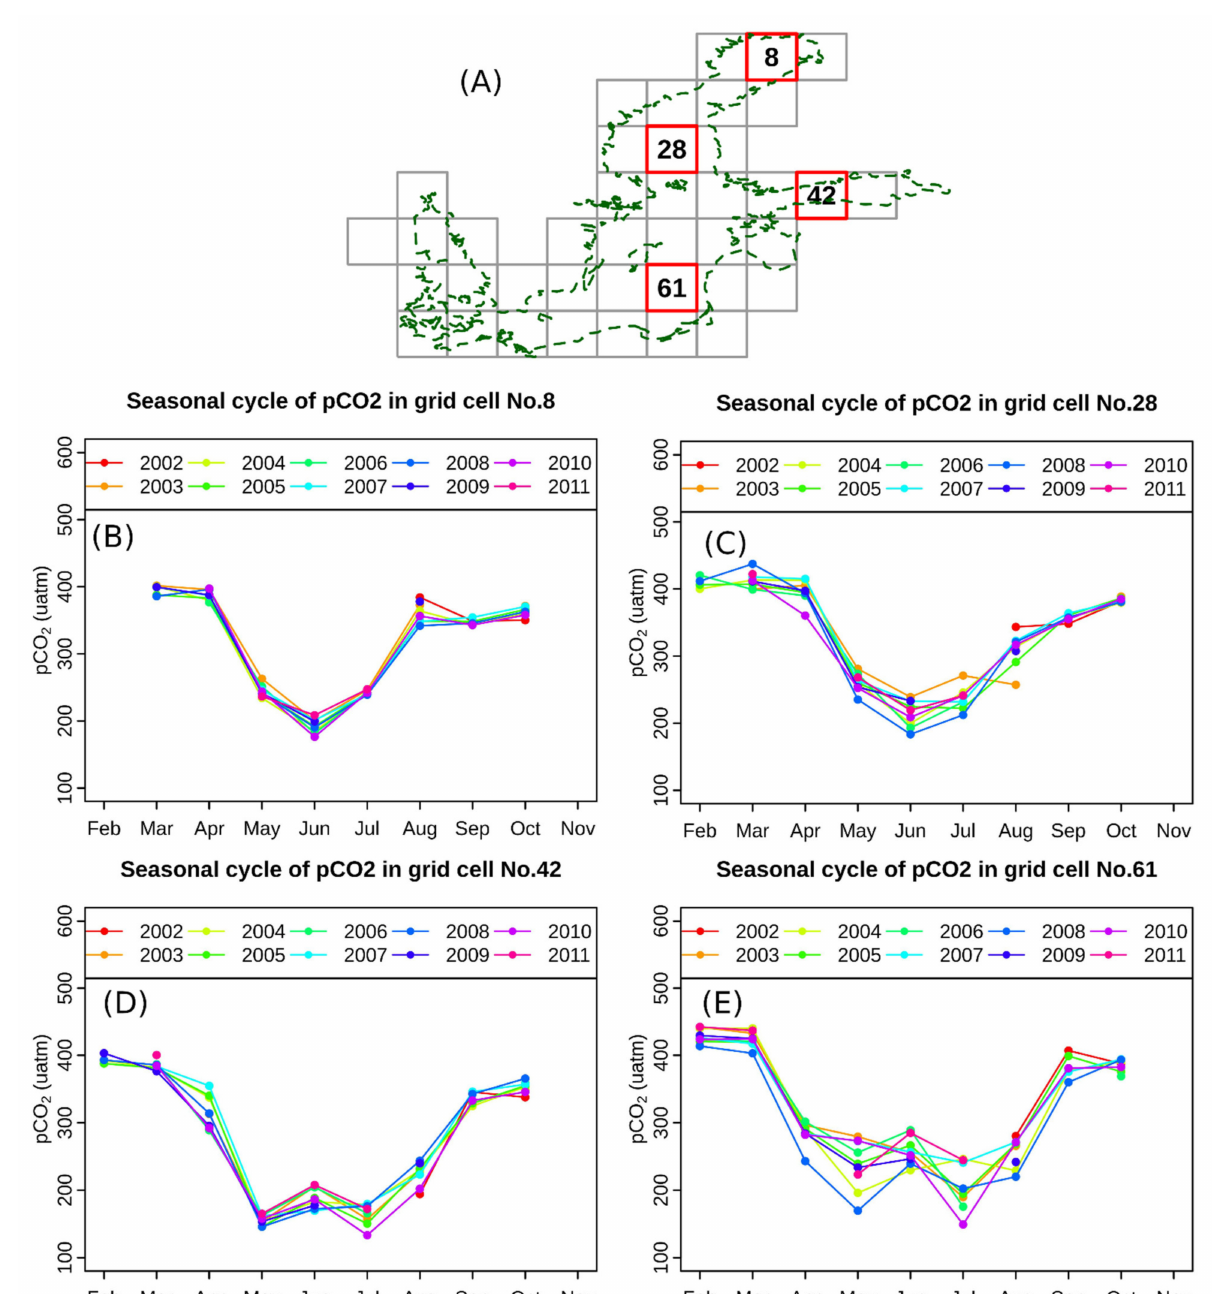
Figure 6. Seasonal cycle of monthly pCO 2 at different sites in the Baltic Sea. The pCO 2 estimate for the months deter- mined with significant upwelling effect in Section 4.2 were excluded from this analysis. ( A ): the location of the sites, ( B – E ): the seasonal cycle of monthly pCO 2 at sites in sub-figure